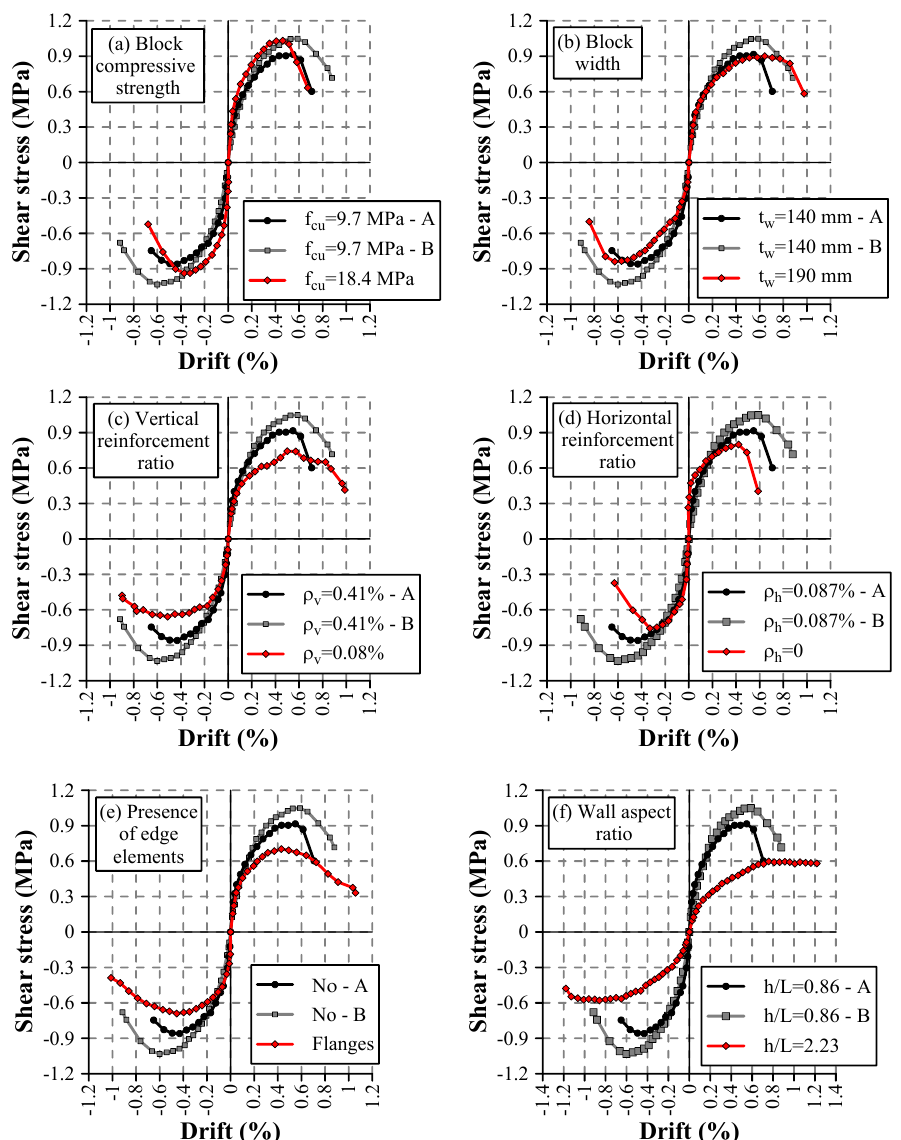
Figure 7. Comparison of envelope curves of walls with different: ( a ) block compressive strength, ( b ) block width, ( c ) vertical reinforcement ratio, ( d ) horizontal reinforcement ratio, ( e ) presence of edge elements, and ( f ) wall aspect